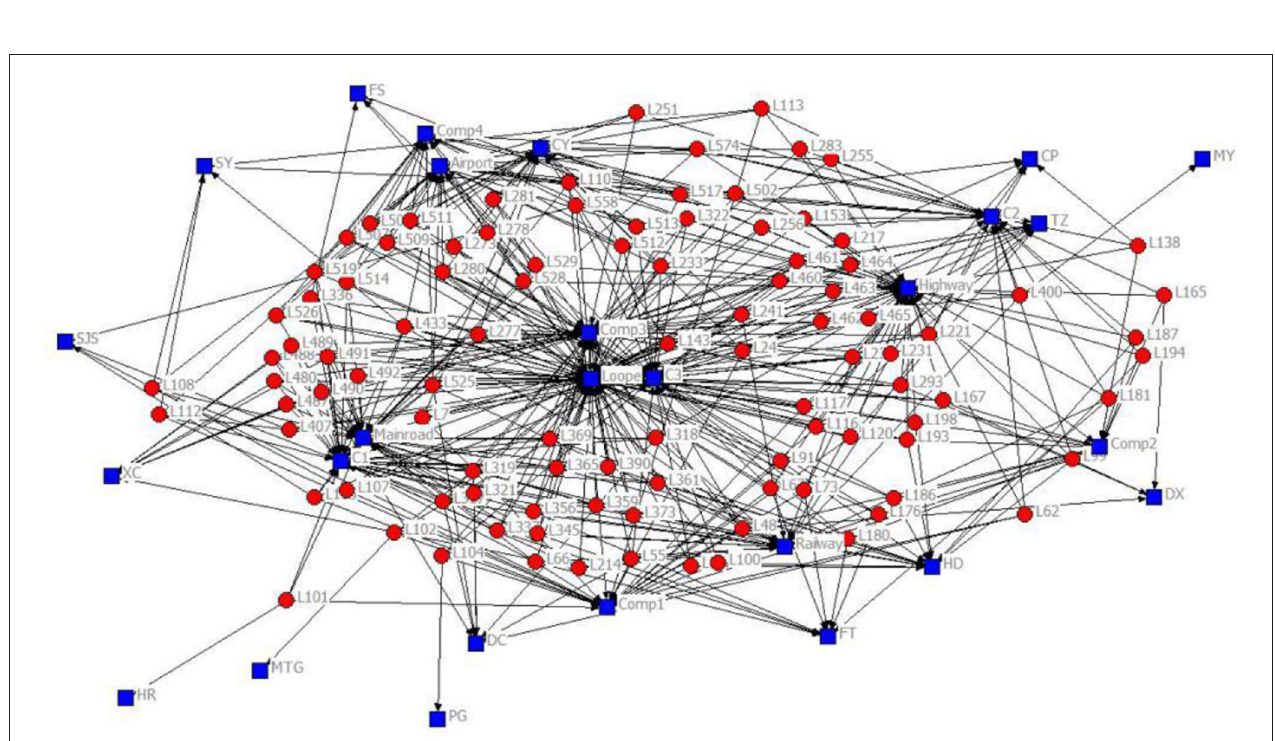
FIGURE 3 | 2-Mode Network of Distribution centers and Local Conditions in the Heuristic Solution of Case 3 (Solution = 101).